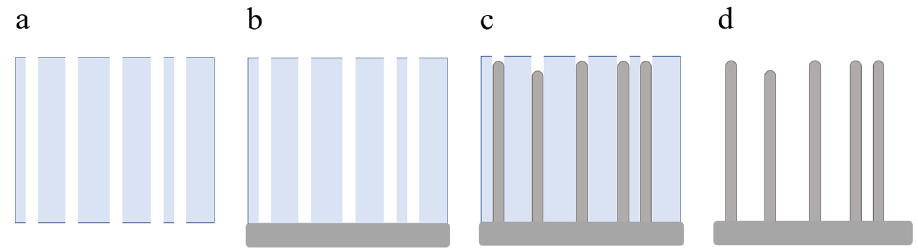
Figure 1. Scheme of the template synthesis of silver NWs: ( a ) initial TM, ( b ) formation of a conductive layer, ( c ) electrochemical deposition of metal into the pores of TM, ( d ) TM removal.